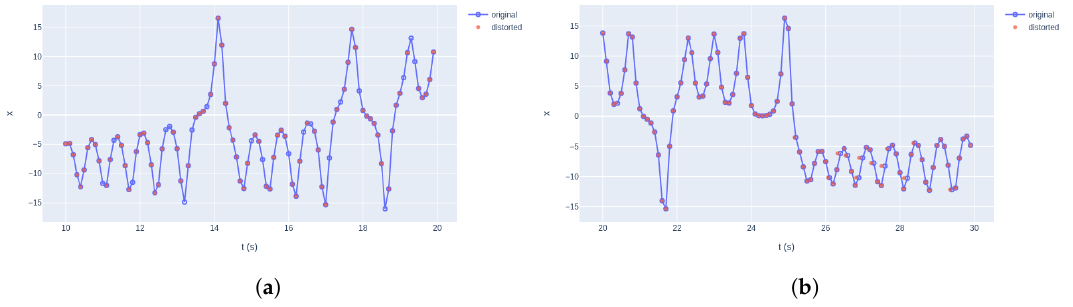
Figure 6. Zoomed distortions of Lorenz first dimension. ( a ) Removed data. ( b ) Shifted